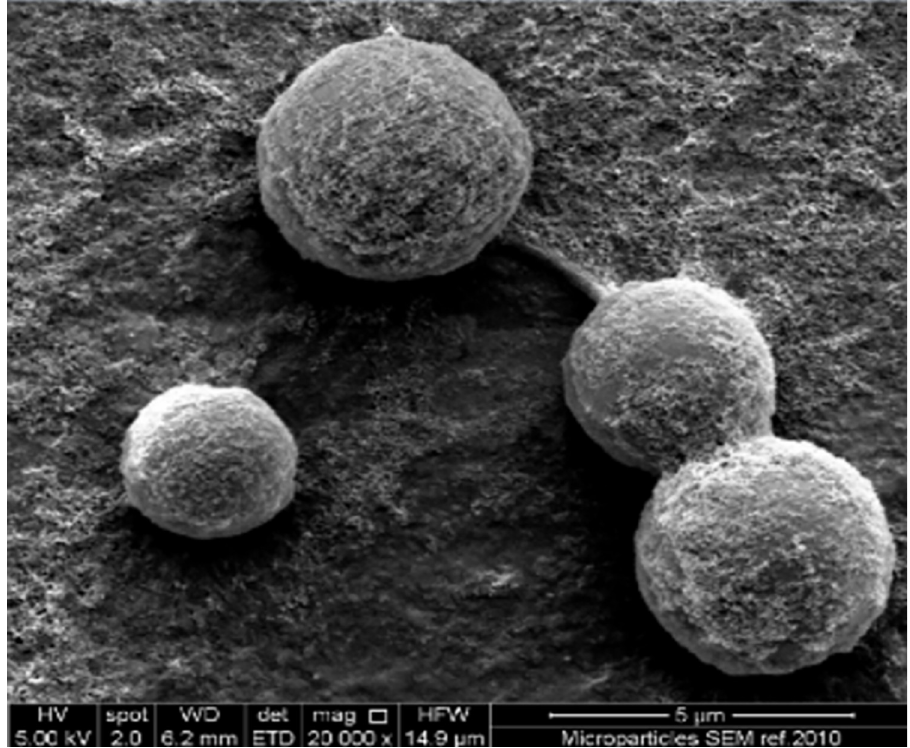
Fig 3. Scanning electron micrograph of blank Eudragit E100 microparticles. Scale bar indicates 5 μ m.